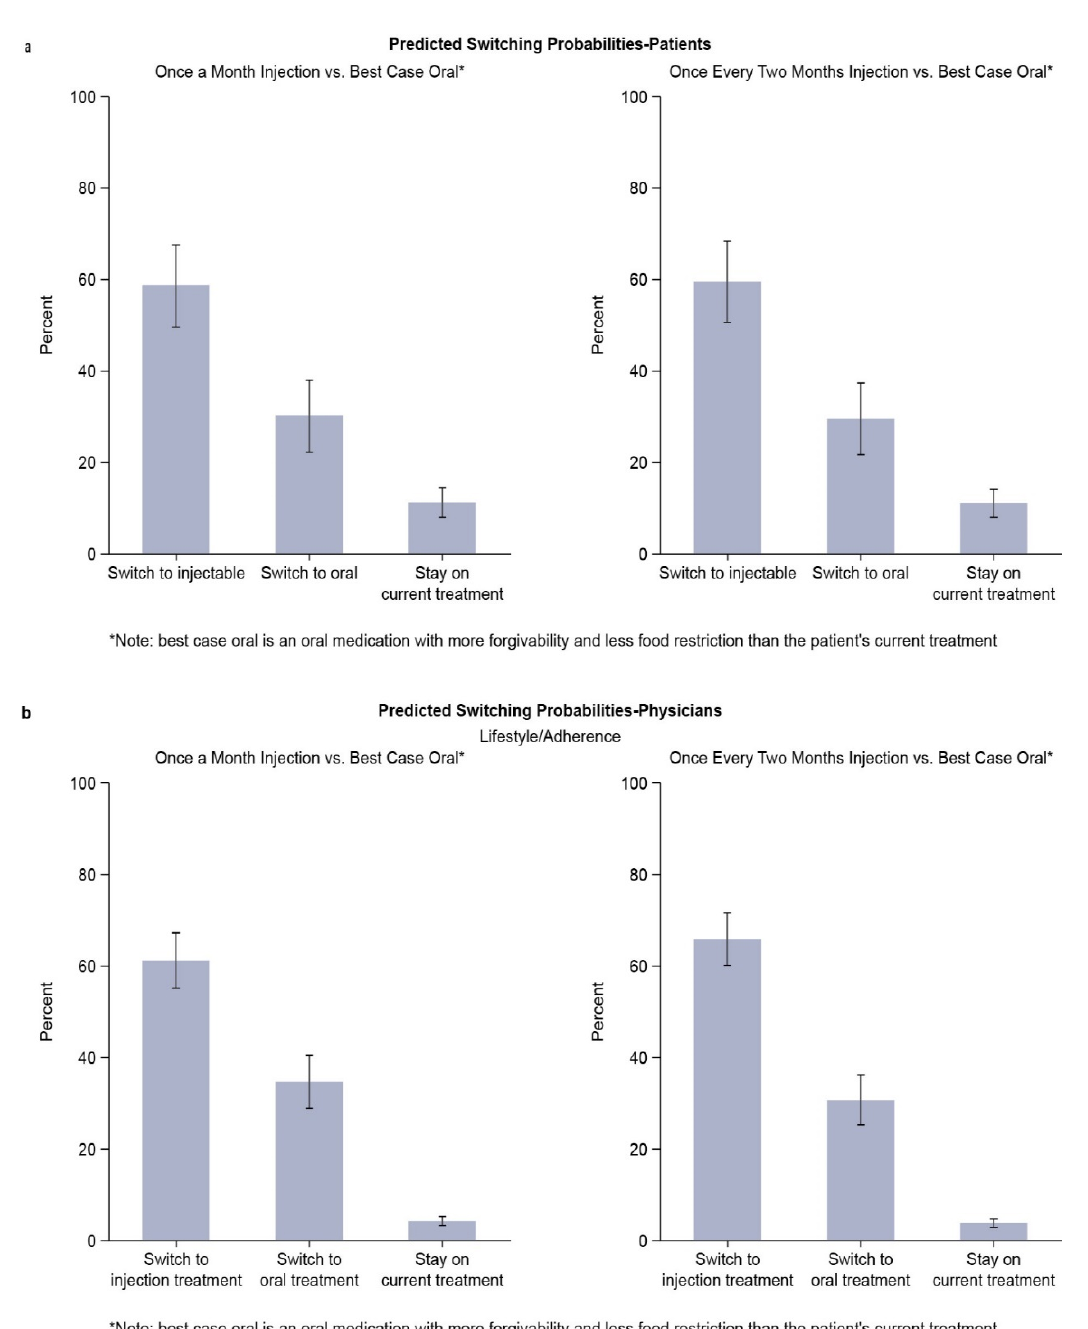
Figure 3. ( a ) Switching probabilities (best-case oral): PLWH. ( b ) Switching probabilities (best-case oral): physician; lifestyle and adherence challenge. PLWH—people living with HIV.